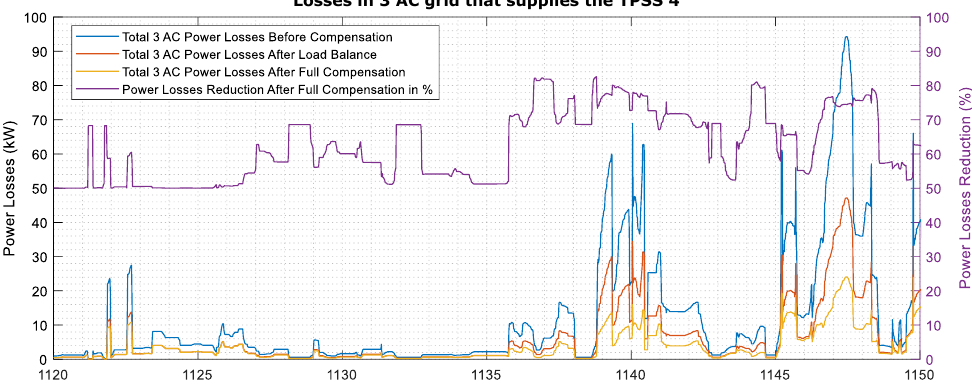
Figure 17. Power losses and losses reduction in the three-phase grid supplying the TPSS 4 with different compensation options.